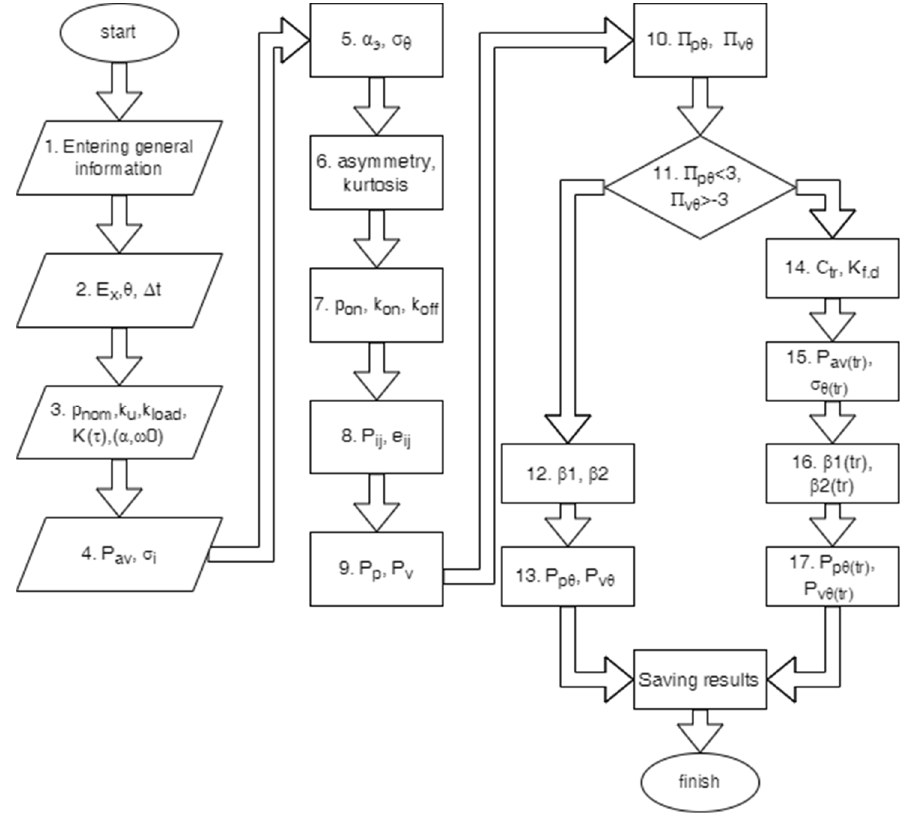
Figure 9. Algorithm for calculating the parameters of electrical load curves.